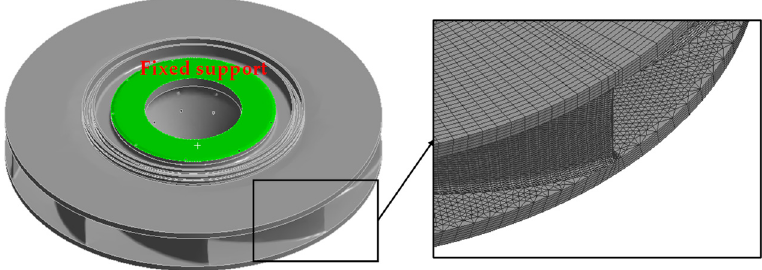
Figure 3. FEM model and boundary condition of runner.